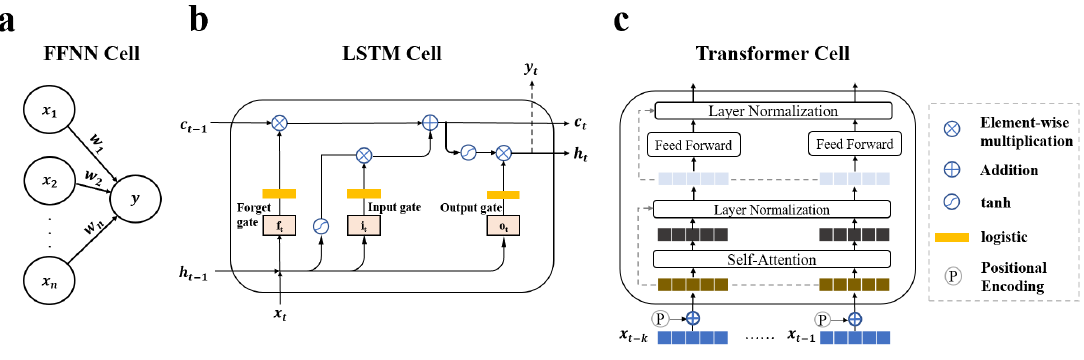
Figure 5. Illustration of the building blocks of the three neural network candidates used in our study. Symbols in the graphs are summarized in the panel on the right. ( a ) A representative subset of a FFNN consisting of multiple pre-synaptic cells and one post-synaptic cell. ( b ) A single cell of an LSTM. ( c ) A single block of a